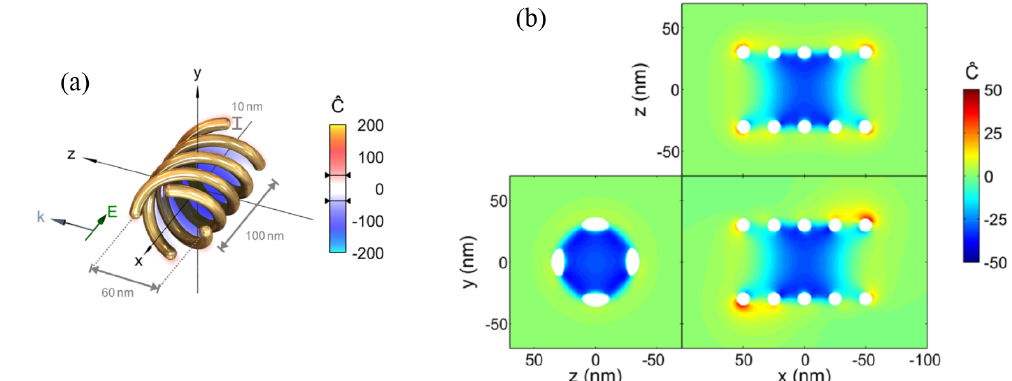
Figure 1. ( a ) Schematics of a plasmonic helix with a pitch of 100 nm and a diameter of 60 nm for the excitation of enhanced chiral near-fields. Due to the chiral geometry of the helix, the chiral density can be excited even from incident linearly polarized fields, as depicted. ( b ) Slice plots confirming the enhanced chiral density in the interior region of the helix due to the excitation of plasmonic resonances. The results shown are for an incident wavelength λ = 1630 nm. Reproduced with permission from ref. [19]. Copyright 2014 American Chemical